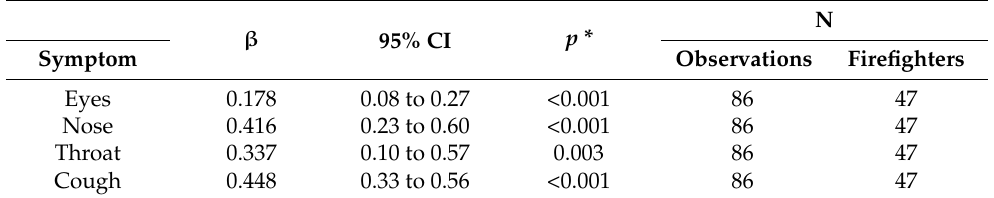
Figure 1. Plot of the extent to which cough bothersome at the start of the next rotation by extent bothersome at the end of previous rotation. Table 9. Relation of start of rotation symptoms to symptoms at the end of the previous rotation (rotations 2–4